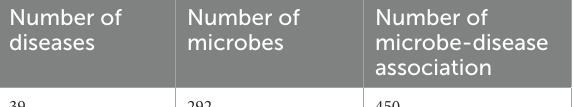
TABLE 1 Data features of verified microbe-disease